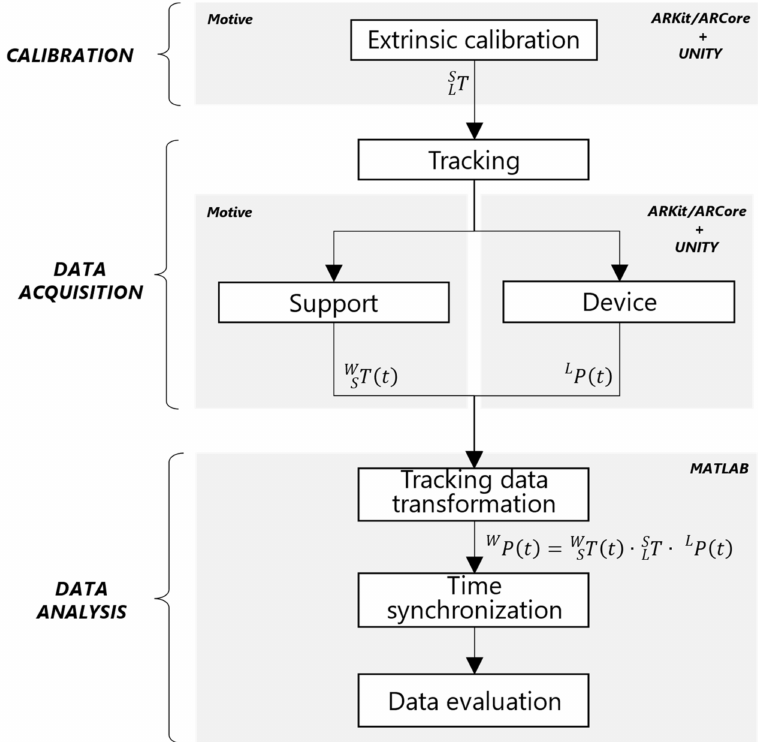
Figure 3. A schematic overview of the evaluation framework adopted for the acquisition and comparison of the tracking data.